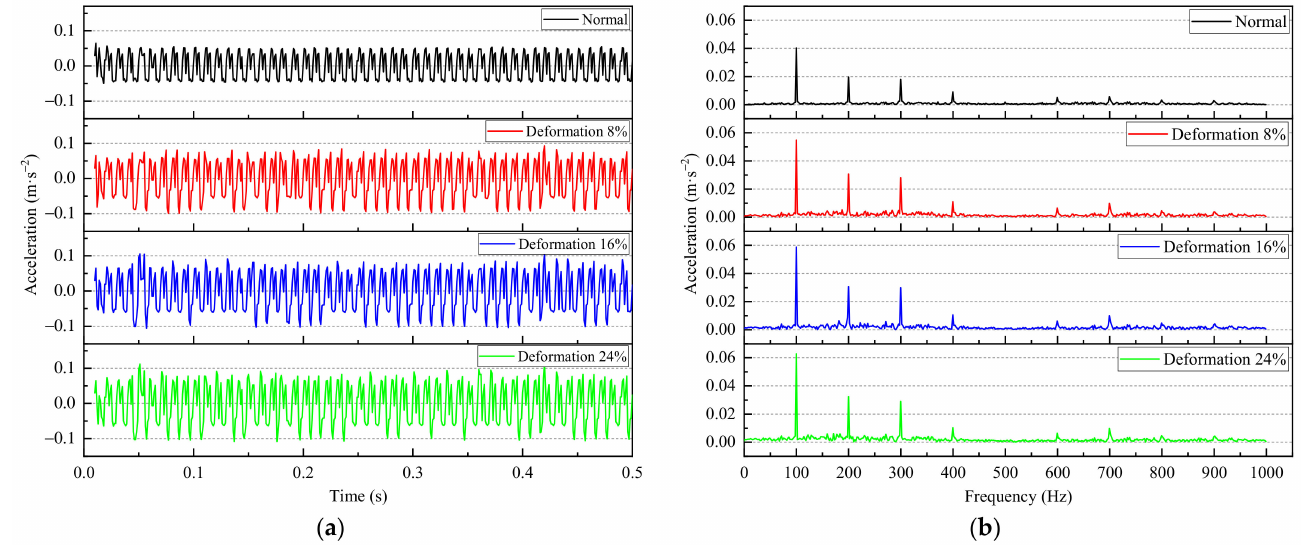
Figure 13. Acceleration signal at winding surface point 1 under normal and different deformation faults. ( a ) Time domain signal of acceleration under normal and deformation conditions; ( b ) frequency domain signal of acceleration under normal and deformation